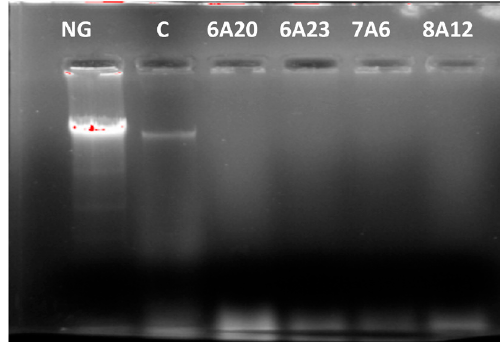
Fig. 3. Activity gel analysis of DNase activity exhibited by the crude extracts of selected bacterial isolates